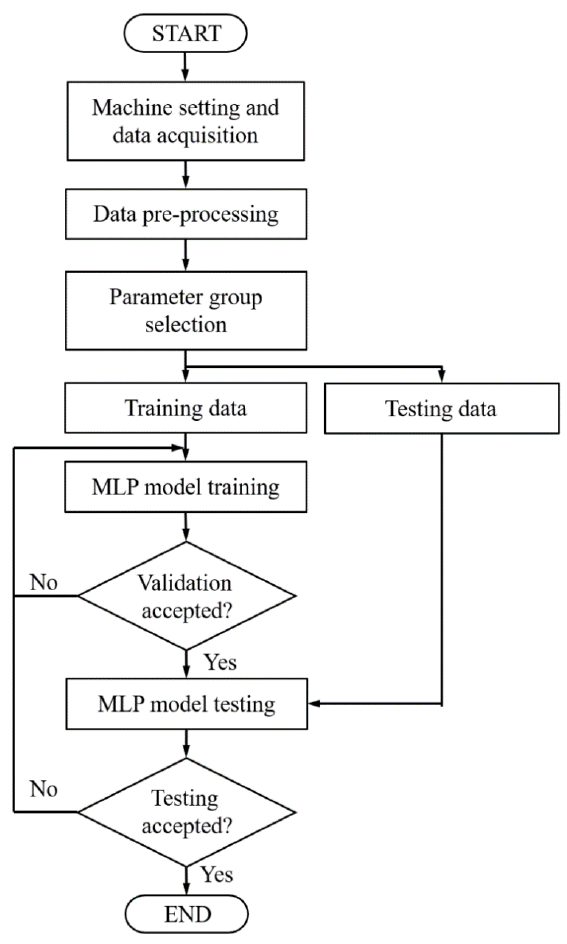
Figure 10. Flowchart of MLP modeling.